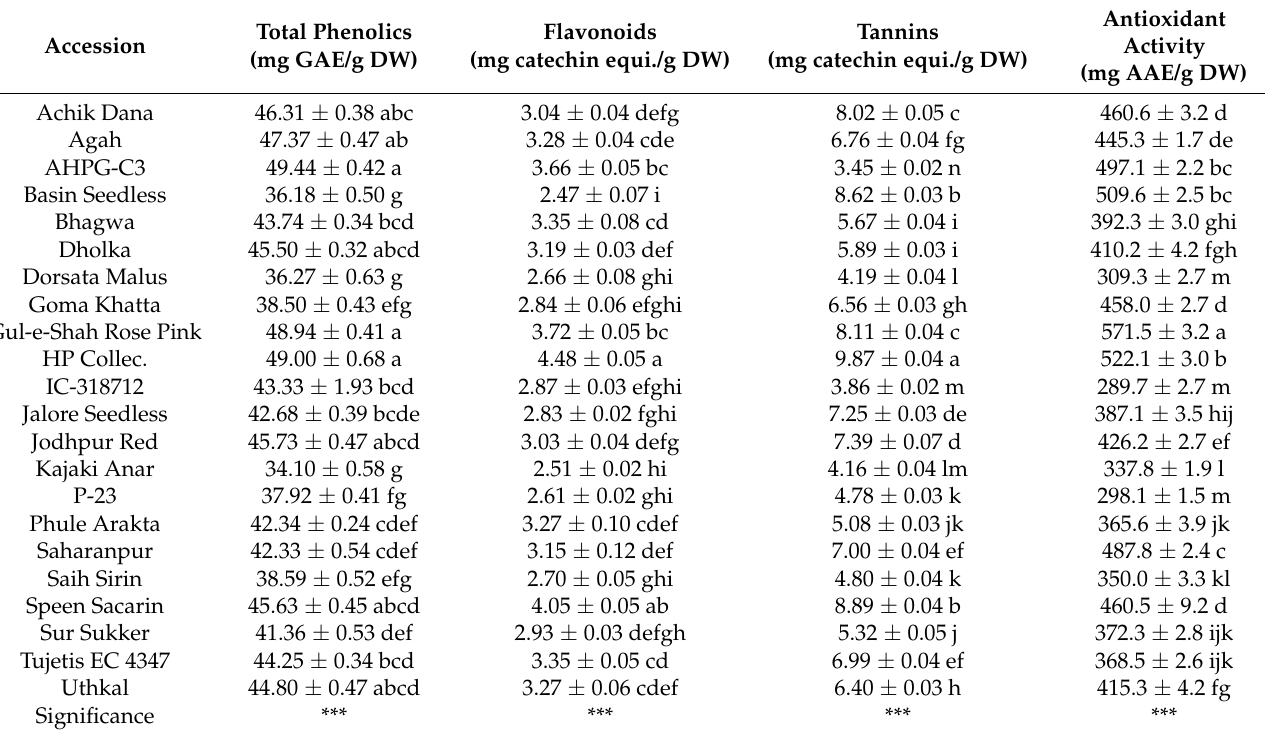
Table 3. Leaf total phenolics, flavonoids, tannins, and antioxidant activity in 22 accessions of pomegranate. Within each column, means followed by a common letter are not significantly different according to the Tukey test ( p ≤